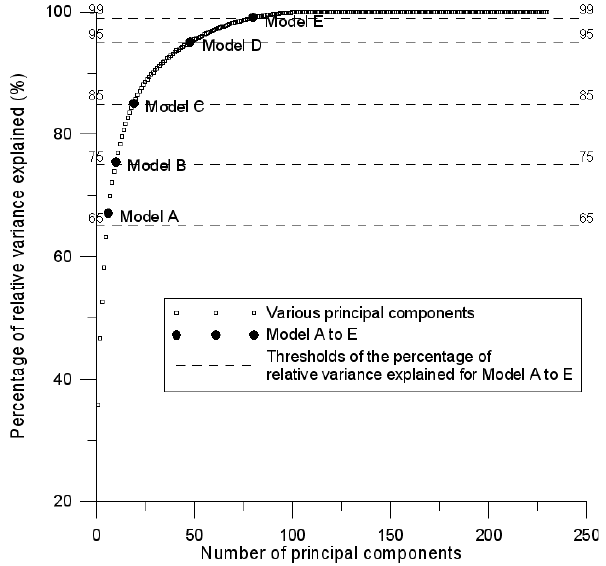
Fig. 7. Percentage of relative variance explained with different prin- cipal